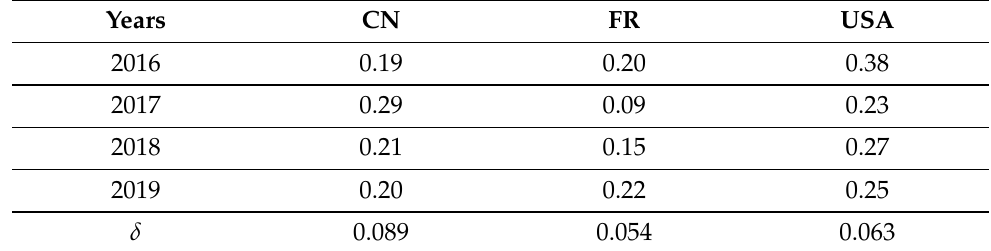
Table 3. Calculated investment attractiveness (feedback